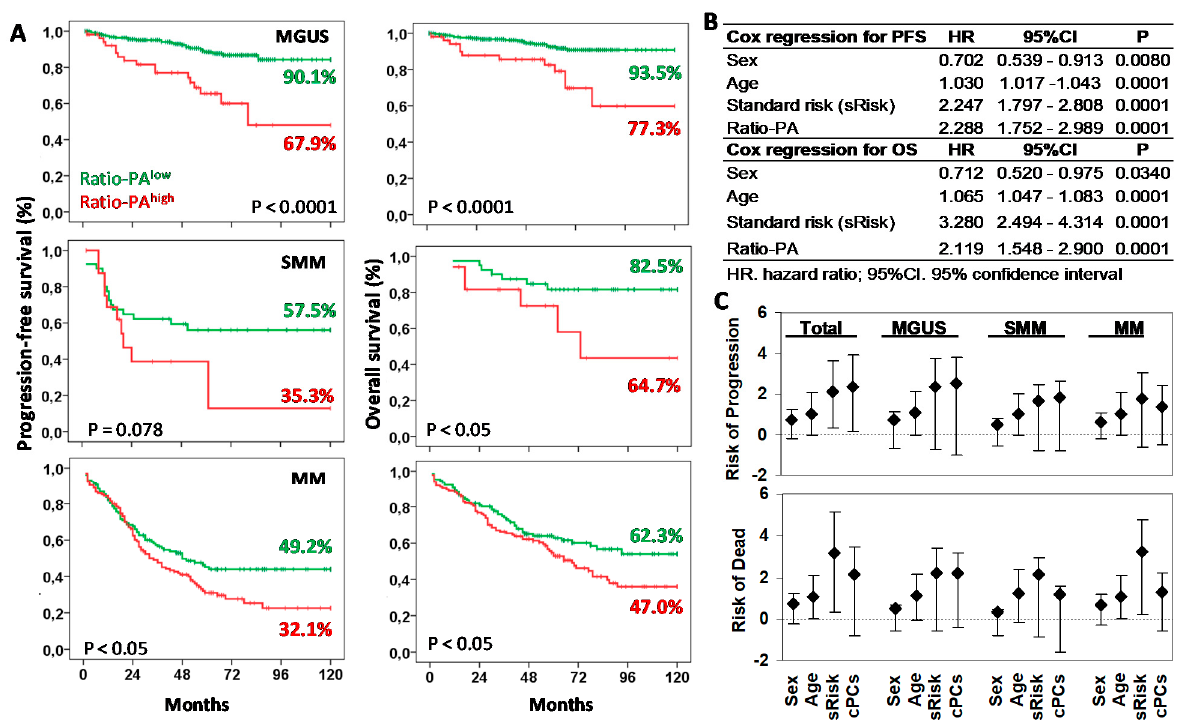
Figure 3. Prognostic capacity of Ratio-PA high for progression-free survival (PFS) and overall survival (OS) of plasma cell neoplasm (PCN) stages. ( A ) Kaplan-Meier and Log-rank tests for PFS and OS according to the high or low Ratio-PA in patients with monoclonal gammopathy of undetermined significance (MGUS), smoldering multiple myeloma (SMM), or multiple myeloma (MM). Ten-year PFS and OS are indicated in the plots. ( B ) Cox regression analysis for PFS and OS for sex, age, standard risk stratification (sRisk), and Ratio-PA of bone marrow plasma cells in total patients. ( C ) Hazard ratio (HR) and 95% confidence interval for progression or death in total, MGUS, SMM, and MM patients observed in the Cox regression analysis.